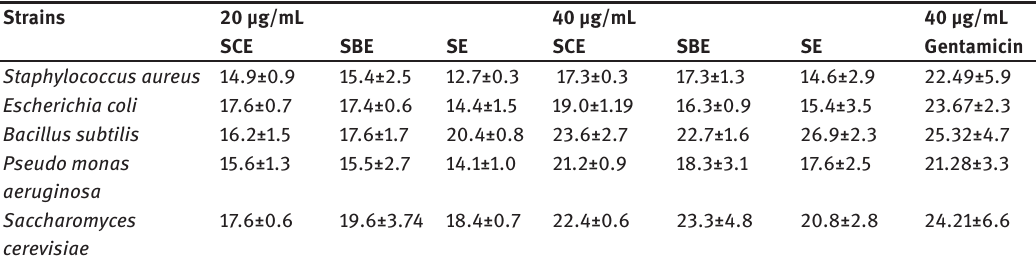
Table 2: Antimicrobial activities of essential oils extracted by 3 methods from cumin.